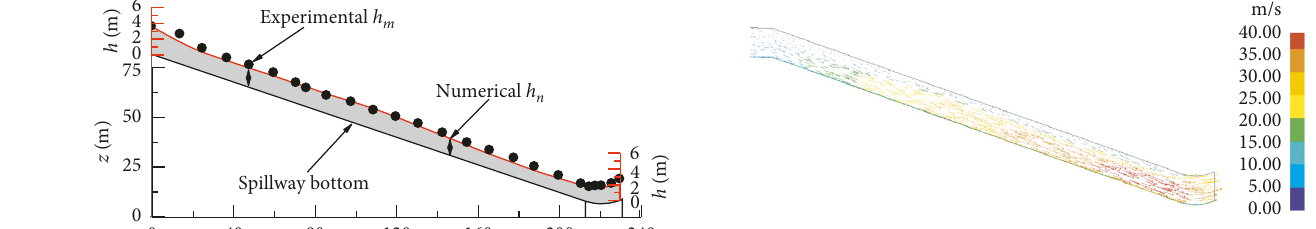
Figure 10: Velocity distribution in the central plane.